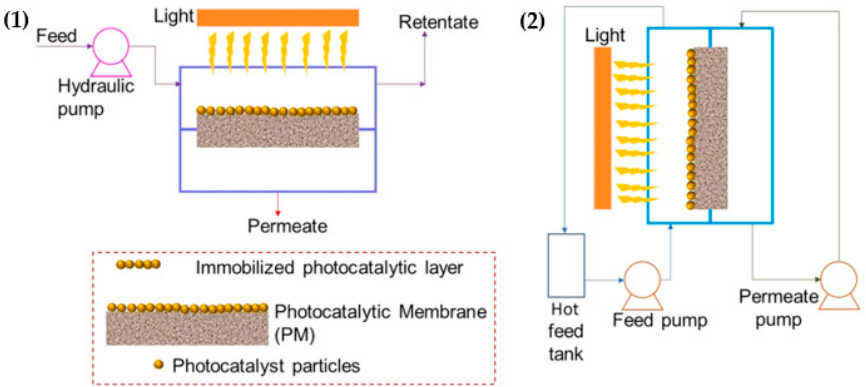
Figure 14. Schematic diagram of PM: ( 1 ) pressure-driven and ( 2 ) non-pressure driven [96]. Repro- duced with permission from Elsevier, 2022. Table 7. The recent advance of TiO 2 -based PM.